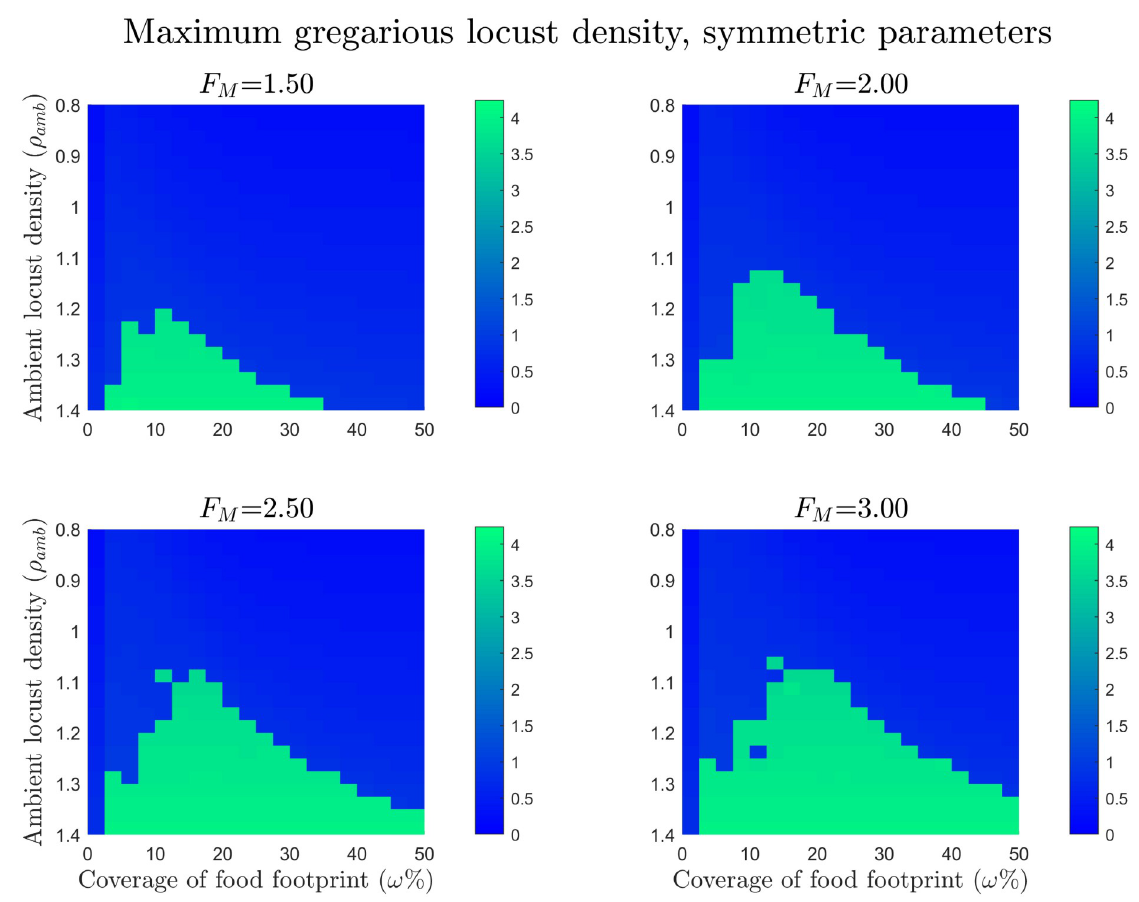
Fig 4. Maximum gregarious locust density for the symmetric gregarisation parameters with varying food footprint sizes and initial ambient locust densities. For the simulations, x = [0, 3/0.14] with periodic boundary conditions and t = [0, 12.5]. The initial condition for locust densities is given by Eq (22) and food initial conditions are given by Eq (23). Ambient locust density ranges from ρ amb = 0.8 to ρ amb = 1.4, food footprint ranges from ω = 0% to ω = 50%, the food mass F = 1.5, 2, 2.5 and 3, and the consumption rate κ = 0.09. The plots show M the maximum peak gregarious density for the varying food footprint sizes and ambient locust densities, in the blue regions there was no group formation and in the green regions there was successful group formation. From this we can deduce that food lowers the required locust density for group formation and this is more pronounced within an optimal food